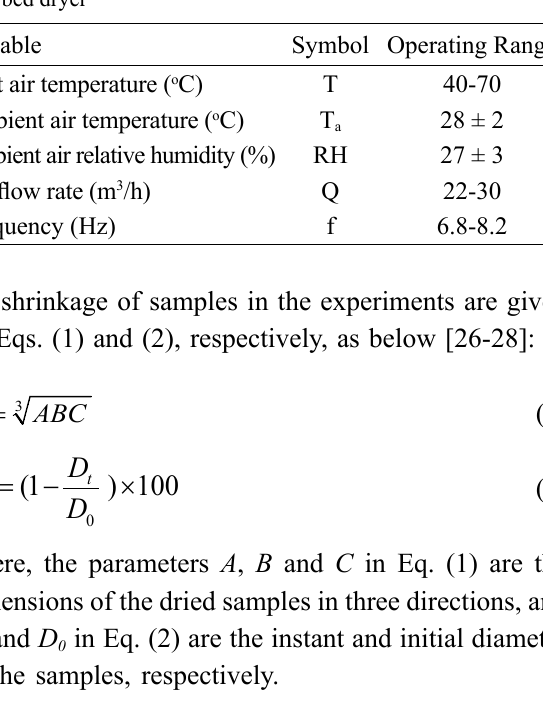
Fig. 1. Photo of hawthorn samples used in the experiments Table 1. The operating range of considered parameters in the